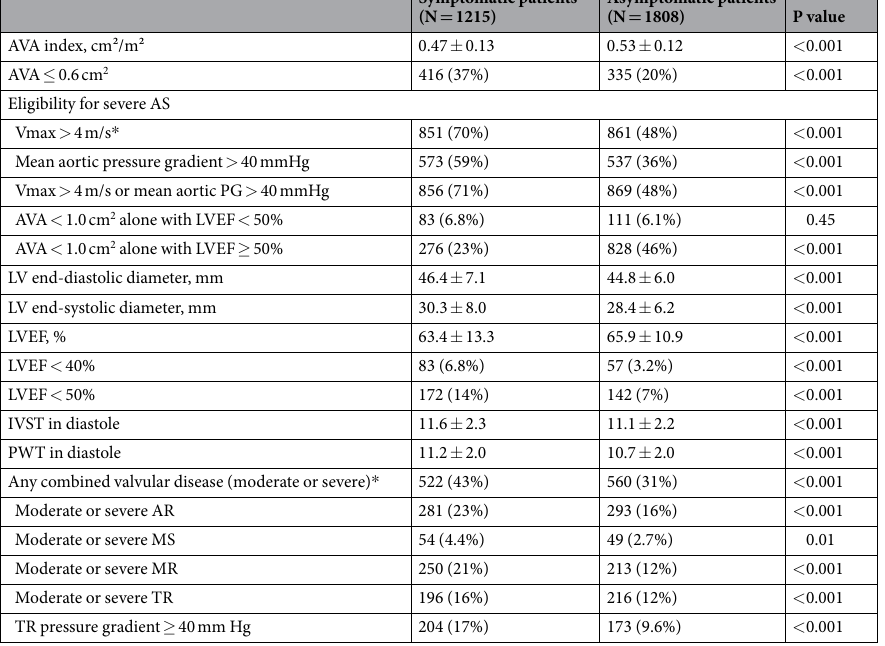
< 0.001 Table 1. Baseline characteristics and echocardiographic parameters. Categorical variables were presented as number (percentage). Continuous variables were presented as mean ± SD, or median (interquartile range). Anemia was defined as hemoglobin < 12.0 g/dl in women and < 13.0 g/dl in men. Coronary artery disease included prior myocardial infarction, prior PCI, prior CABG, or documented coronary artery disease at baseline. * Indicated the covariates incorporated in the multivariable Cox’s proportional hazard models as the risk-adjusting variables. AR = aortic regurgitation; AS = aortic stenosis; AVA = aortic valve area; AVR = aortic valve replacement; BMI = body mass index; BSA = body surface area; CABG = coronary artery bypass grafting; IVST = interventricular septum thickness; LV = left ventricular; LVEF = left ventricular ejection fraction; MR = mitral regurgitation; MS = mitral stenosis; PCI = percutaneous coronary intervention; PG = pressure gradient; PROM = predicted risk of mortality; PWT = posterior wall thickness; STS = Society of Thoracic Surgeons; TR = tricuspid regurgitation; Vmax = peak aortic jet